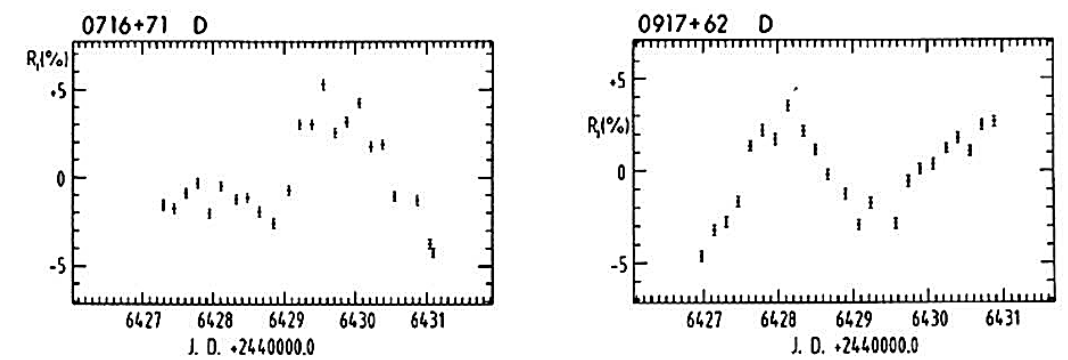
Figure 2. 2.7 GHz observations of 0716+71 and 0917+62 with the Effelsberg 100 m telescope, from [13] DOI:10.1086/114583. c (cid:13) AAS. Reproduced with permission from AAS.